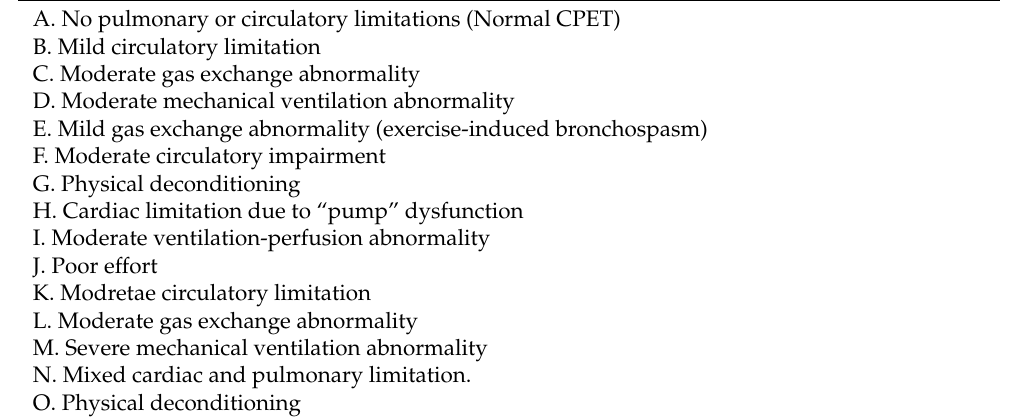
Figure 1. RER: respiratory exchange ratio; PVO 2 : peak oxygen consumption; VR: ventilatory reserve; AT: anaerobic threshold; VE/VCO 2 : ventilatory equivalent for carbon dioxide; HRR: heart rate reserve; SaO 2 : oxygen saturation; OUES: oxygen uptake efficiency slope; VD/VT: dead space ventilation/tidal ventilation; NL: normal; ABNL: abnormal. Table 3. Interpretation using the algorithm (Figure 1).